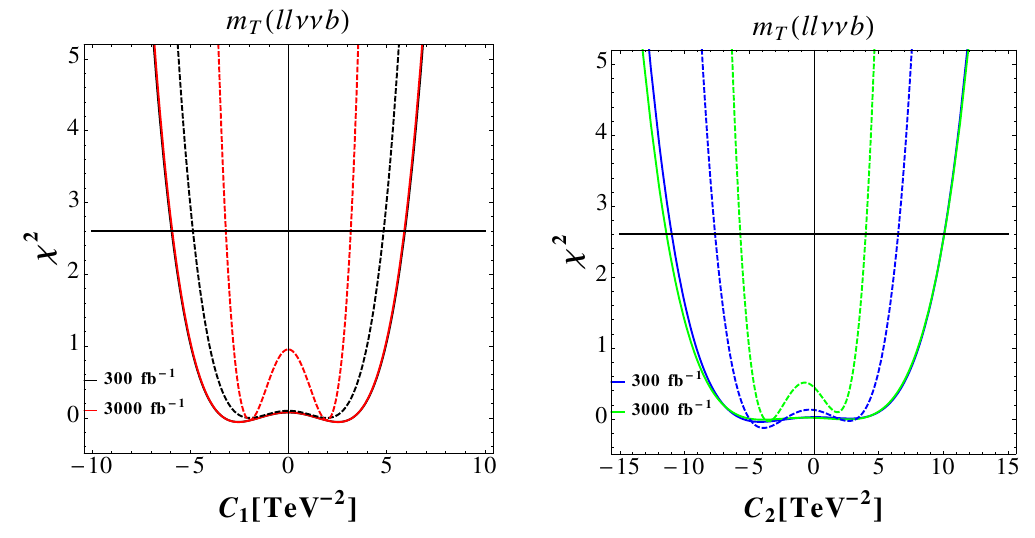
Figure 6 . Expected behavior of the reduced (cid:31) 2 as function of the e(cid:11)ective operator coe(cid:14)cients C 1 (left plot) and C 2 (right plot) obtained using the m T distribution. In the left plot, the black solid (dashed) curve corresponds to the pessimistic (optimistic) scenario for 300 fb (cid:0) 1 , while the red solid (dashed) curve corresponds to the pessimistic (optimistic) scenario for 3000 fb (cid:0) 1 . In the right plot, the blue solid (dashed) curve corresponds to the pessimistic (optimistic) scenario for 300 fb (cid:0) 1 , while the green solid (dashed) curve corresponds to the pessimistic (optimistic) scenario for 3000 fb (cid:0) 1